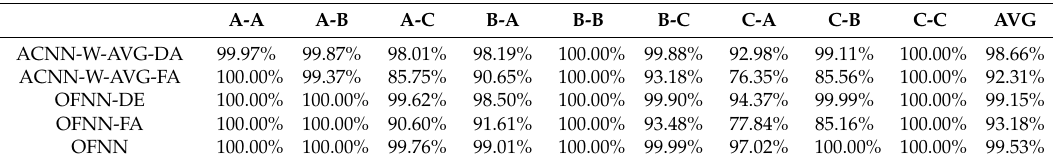
Table 4. Comparison of different methods over 20